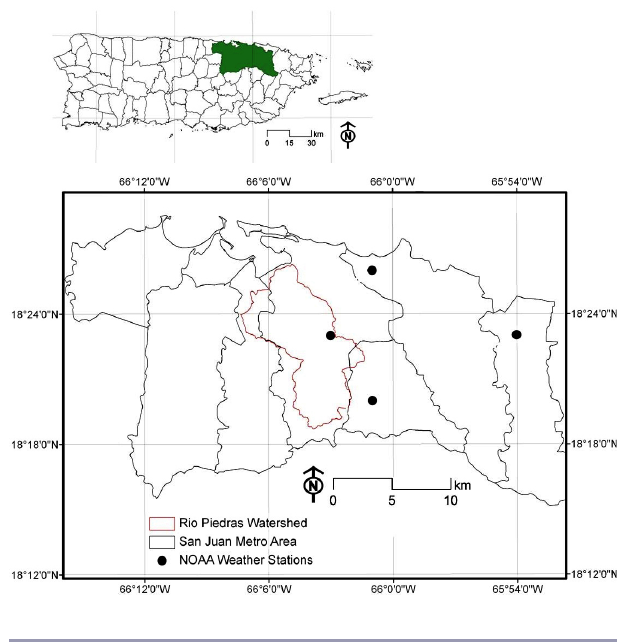
Fig. 1 . San Juan metropolitan area and National Oceanic and Atmospheric Administration (NOAA) weather stations.